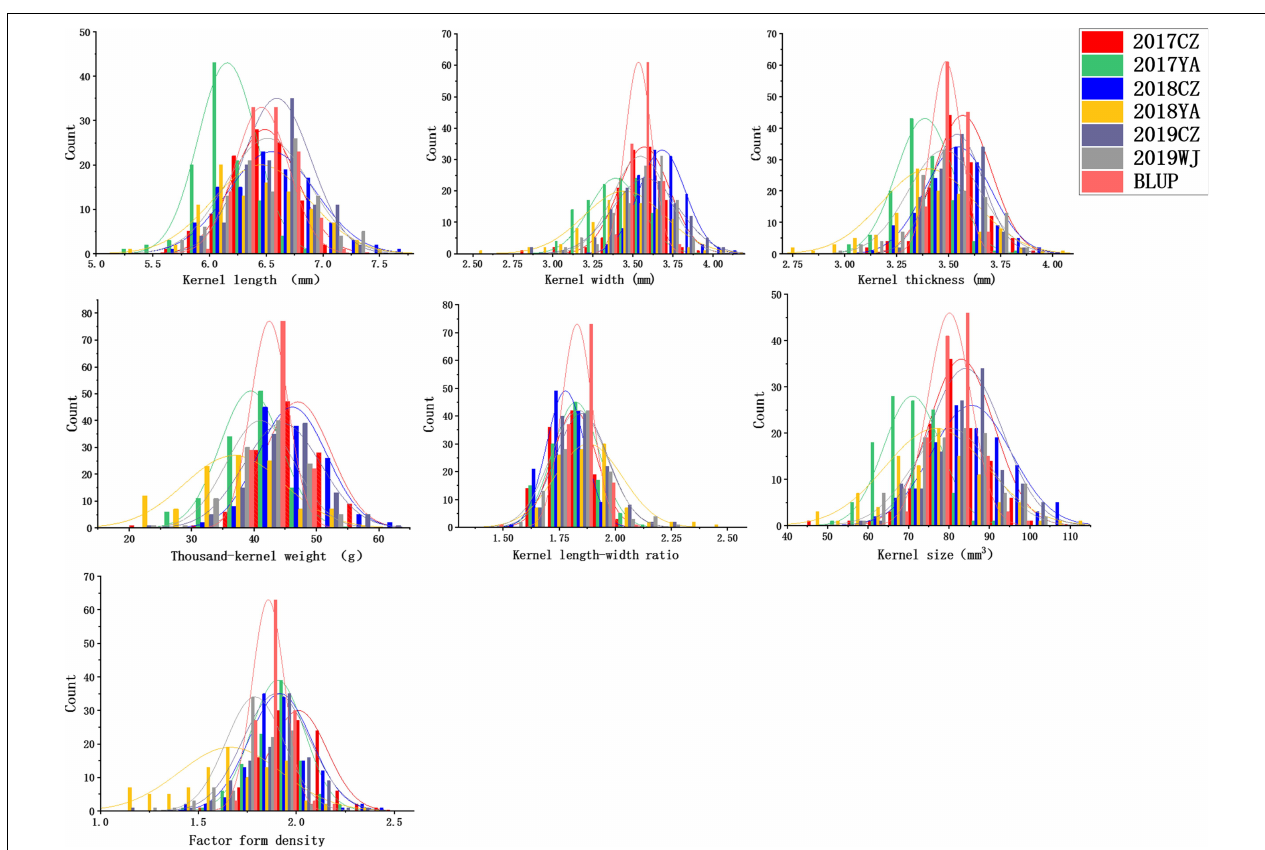
FIGURE 2 | Frequency distributions for kernel length (KL), kernel width (KW), kernel thickness (KT), thousand-kernel weight (TKW), kernel length–width ratio (LWR), kernel size (KS), and factor form density (FFD) in different